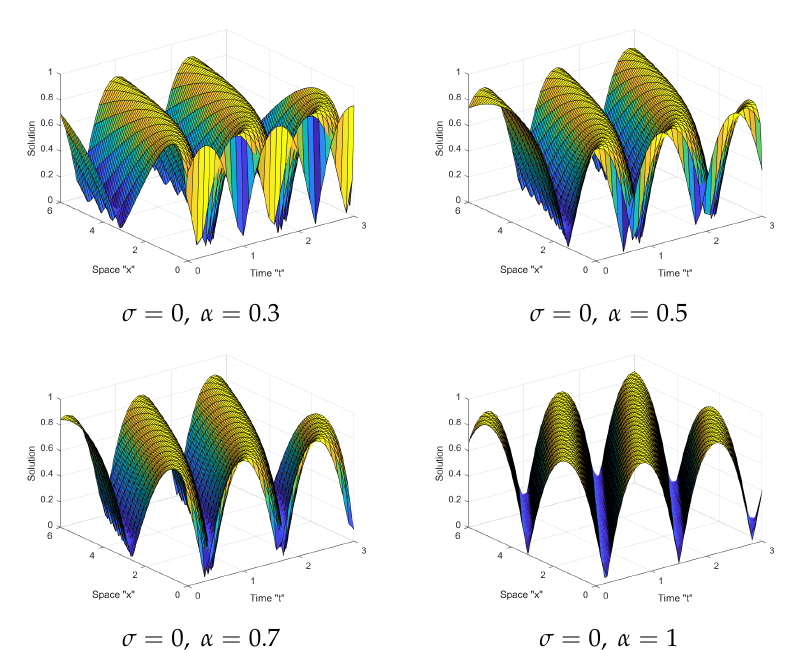
Figure 3. 3D profile of Equation (21) with σ = 0 and various α .